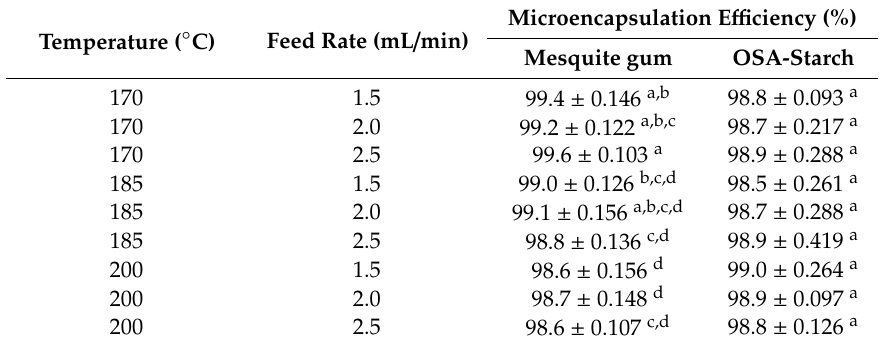
Table 3. Microencapsulation e ffi ciency of the green co ff ee oil according to the experimental design. Temperature ( ◦ C) Feed Rate (mL /